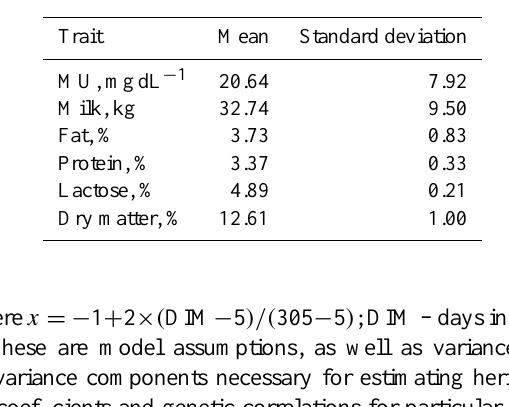
Table 1. Descriptive statistics of the analysed traits ( N =